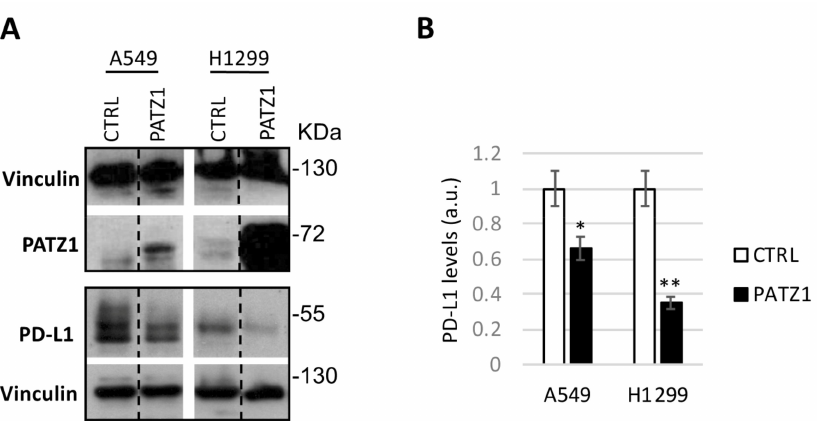
Figure 5. PATZ1 overexpression in lung adenocarcinoma cells reduces PD-L1 expression. ( A ) Western blots using anti-PATZ1 and anti-PD-L1 on total cell extracts of A549 and H1299 cells collected 24 h after transfection with PATZ1-overexpressing plasmid (PATZ1) or empty vector used as control (CTRL). Vinculin was used for normalization. Black dashed lines delineate the boundary between non-contiguous lanes of the same gel. ( B ) Relative PD-L1 levels were quantified by densitometric analysis using Image J (v1.46r), normalized relative to vinculin levels, and expressed relative to each control, arbitrarily set to 1. a.u., arbitrary units. * p < 0.05; ** p < 0.01. The uncropped blots are shown in Figure